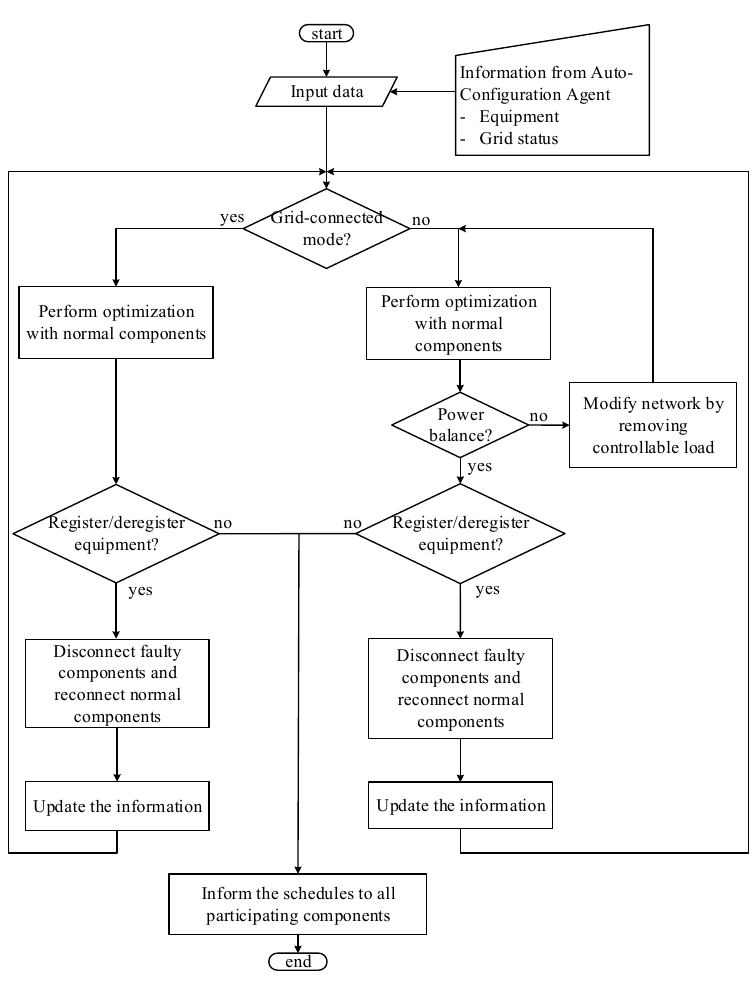
Figure 7. The proposed operation algorithm for EMS.